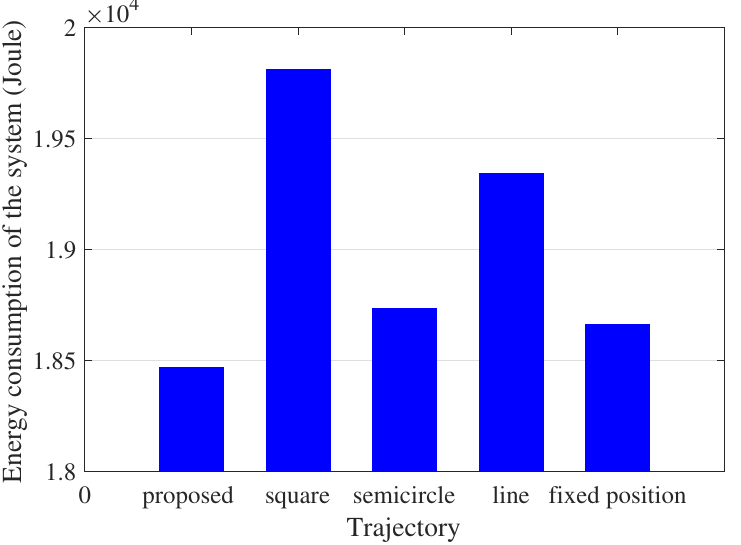
Figure 5. Energy consumption of the UAV-enabled mobile edge computing (MEC) system in different